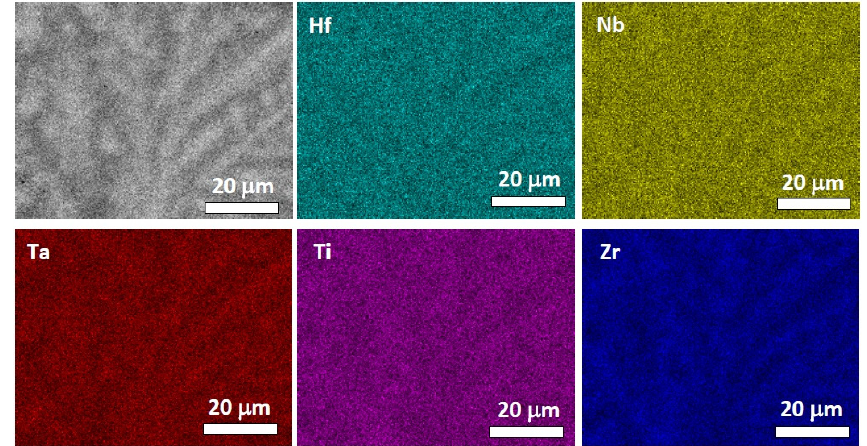
Figure 7. EDS elemental maps of HfNbTaTiZr alloy in the as-cast state (SEM micrograph in the upper left panel shows the inspected region).